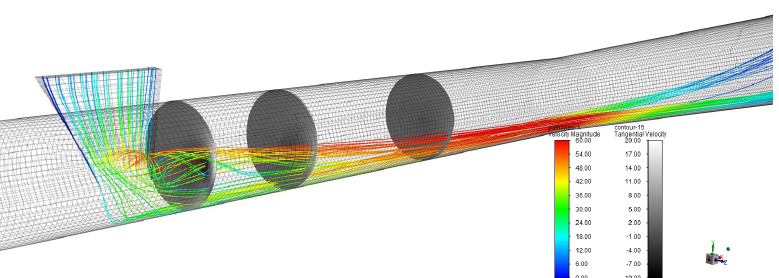
Figure 10. Flowpath illustration of the flow coming from the bypass inlet. Different cross-sectional contour plots of the tangential velocity are shown for locations along the axial direction after the bypass